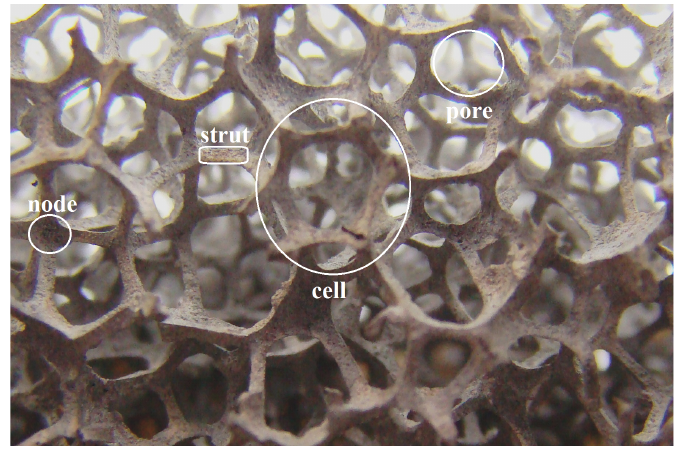
Figure 1. Nomenclature of cast open-cell metal